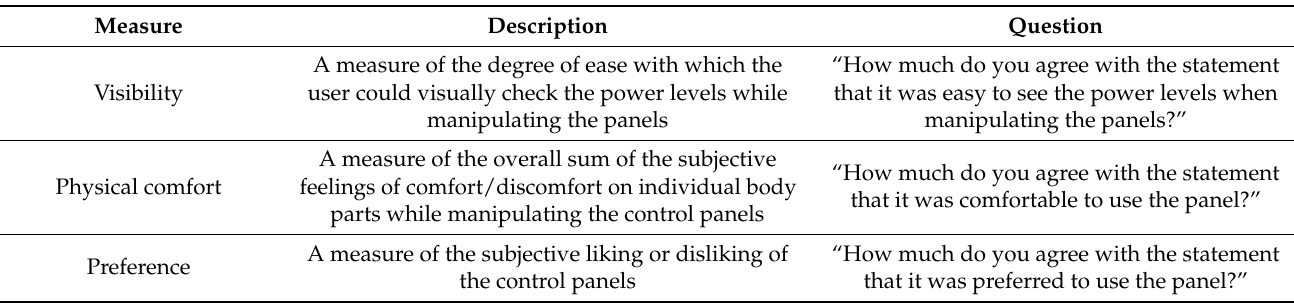
Table 1. Three subjective rating measures.